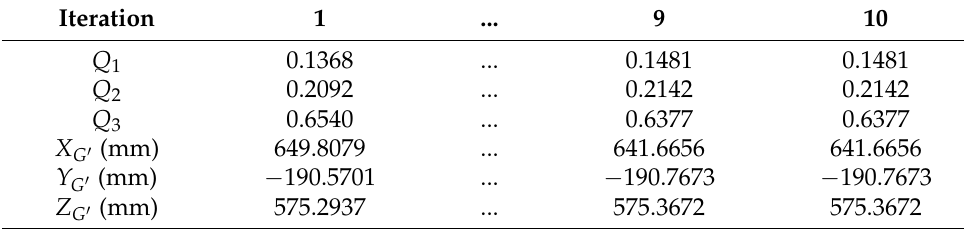
Table 12. The iteration of second